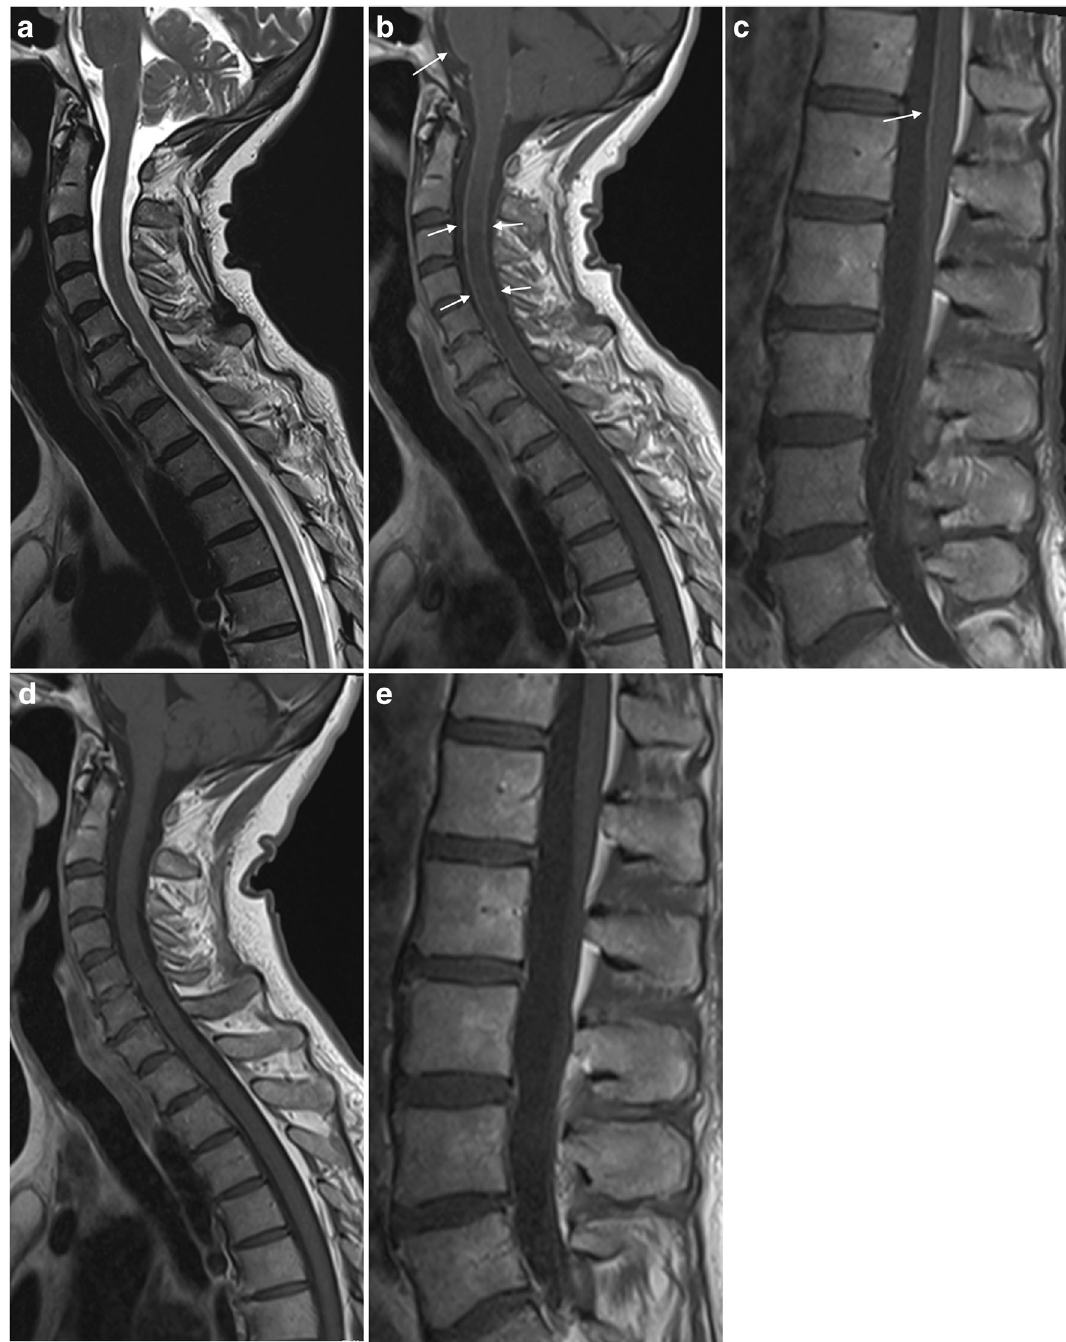
Fig. 1 Meningoradiculitis due to Lyme neuroborreliosis (LNB) in a 73- year-old female. She experienced periods of strong superficial abdominal pain, reduced appetite and headache. Sagittal T2 ( a ) and T1 after gadolinium-based contrast agent injection ( b , c ) demonstrated normal cord parenchyma and diffuse leptomeningeal enhancement (arrows) of